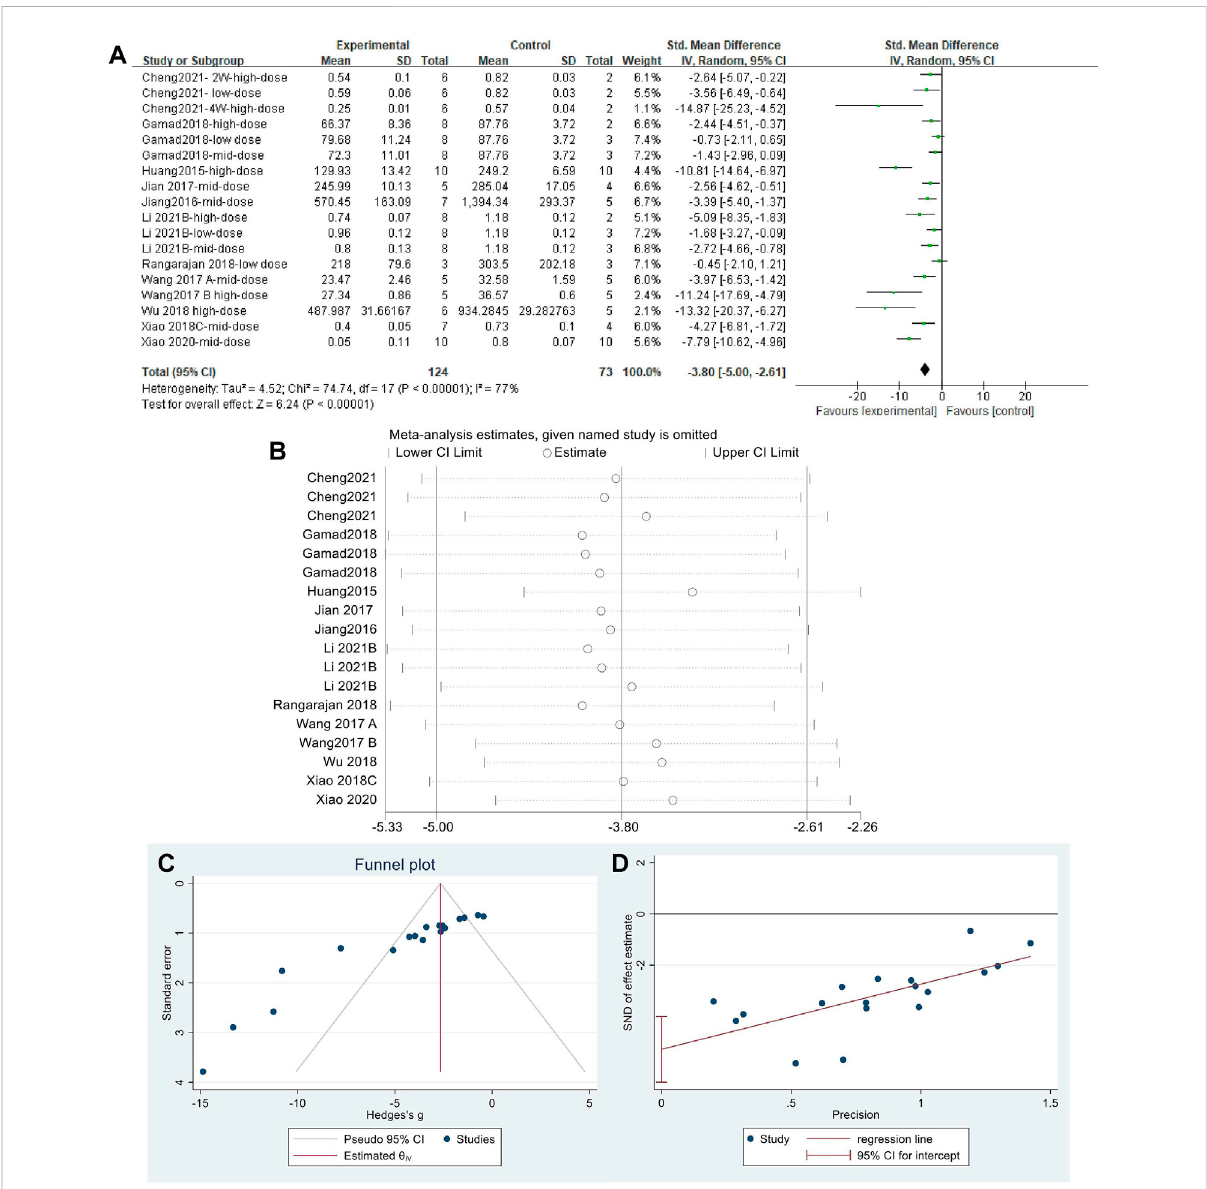
FIGURE 7 Effect of MET on HYP in lung tissues of PF animals. (A) Forest plot of HYP; (B) Sensitivity analysis of HYP; (C) Funnel plot of HYP; (D) Egger ’ s test for HYP.